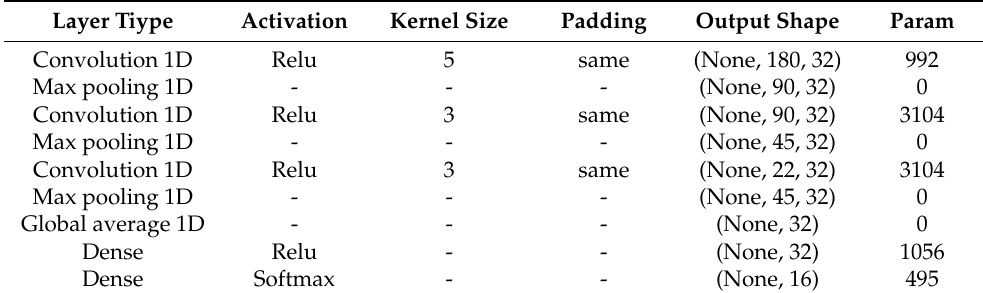
Figure 7. The CNN model used for ShokacChip TM data. Table 6. Hyper parameters of 1-dimension CNN for ShokacChip TM .